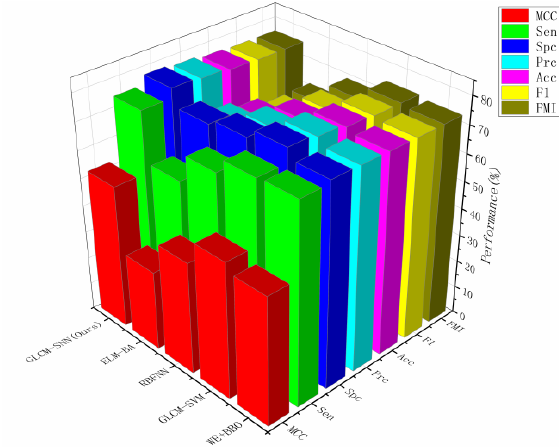
Fig 13. Comparison with State-of-the-art approaches Table 6. 10 runs of 10-fold cross